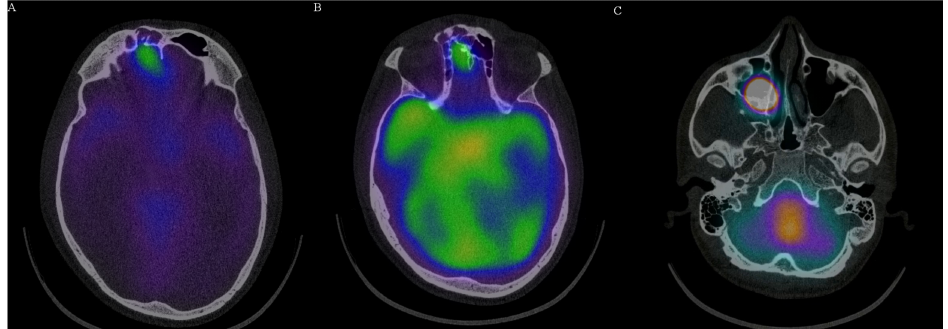
Figure 3. SPECT scanning: ( A ) axial image of increased radioisotope activity over the right frontal sinus with bone defect; ( B ) axial image of increased radioisotope activity over the anterior part cribriform plate with bone defect; ( C ) radioisotope activity in the right maxillary sinus. (Images provided with the courtesy of the Institute on Nuclear and Molecular Medicine, Kosice.).